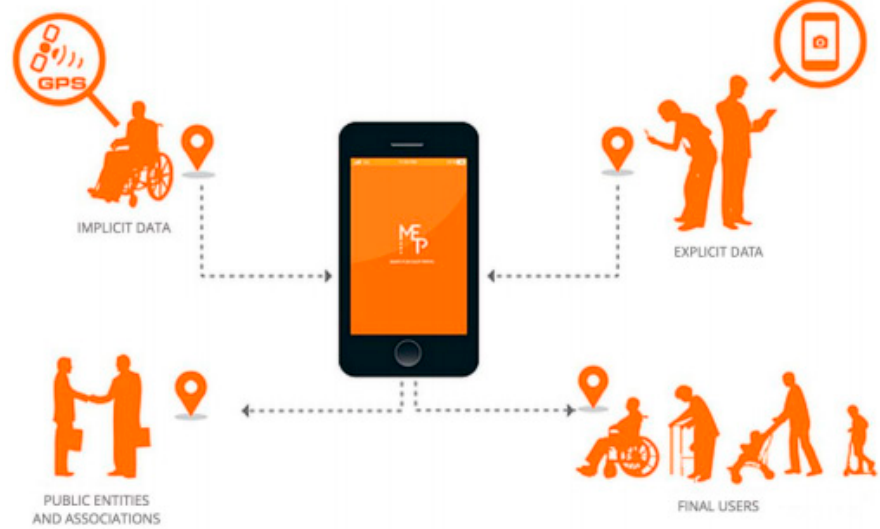
Figure 1. A rough graphical description of the Maps for Easy Paths(MEP) project.